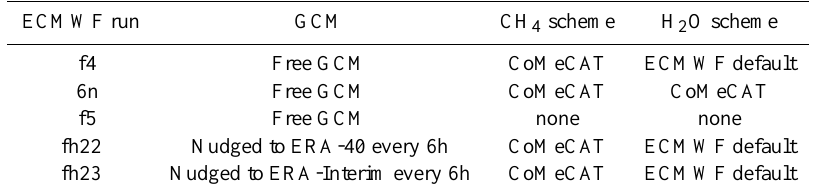
Fig. 2. Altitude–latitude distribution of CoMeCAT CH 4 lifetime τ (inverse of the loss rate). Values of τ are shown, in years, for (a) January, (b) April, (c) July and (d) October. Table 2. ECMWF runs with CoMeCAT CH 4 and H 2 O schemes. The ECMWF GCM has been used in free-running mode or in nudged mode to reanalyses as shown. In all these runs stratospheric CH 4 and H 2 O can come from the CoMeCAT scheme, from the default ECMWF option or remain inactive, as indicated. For the runs included here the CoMeCAT scheme was not interactive with the ECMWF radiation scheme. The meteorology used for the nudged runs corresponds to year